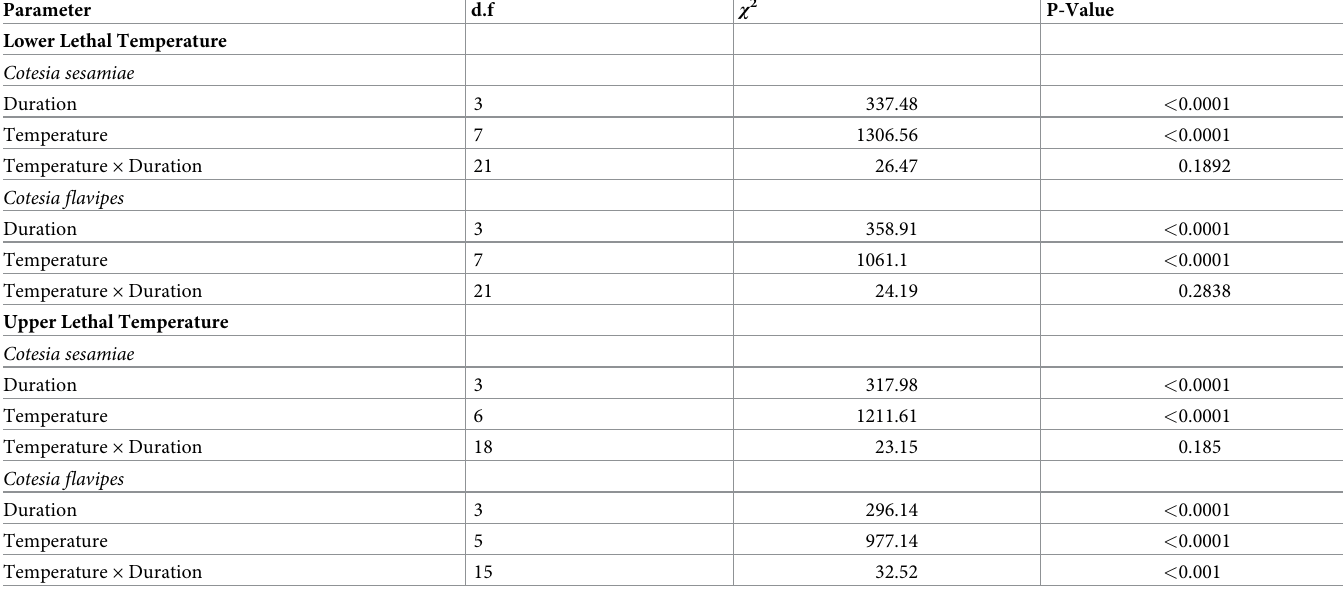
Table 1. Summary statistical results of the effects of temperature, duration of exposure and their interactions on the survival of Cotesiasesamiae and Cotesiaflavipes adults following lower and upper lethal temperature treatments. Analysis were done using generalized linear models (GLZ) assuming binomial distribution with a logit link function in R version